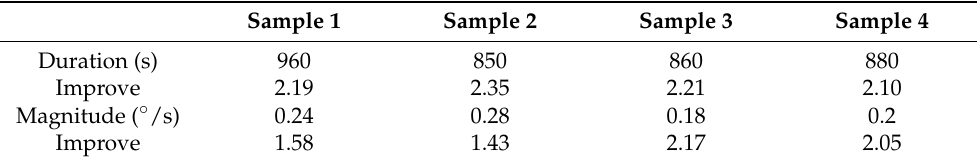
Table 3. The duration and magnitude of ZRO drift after the stress release experiment.